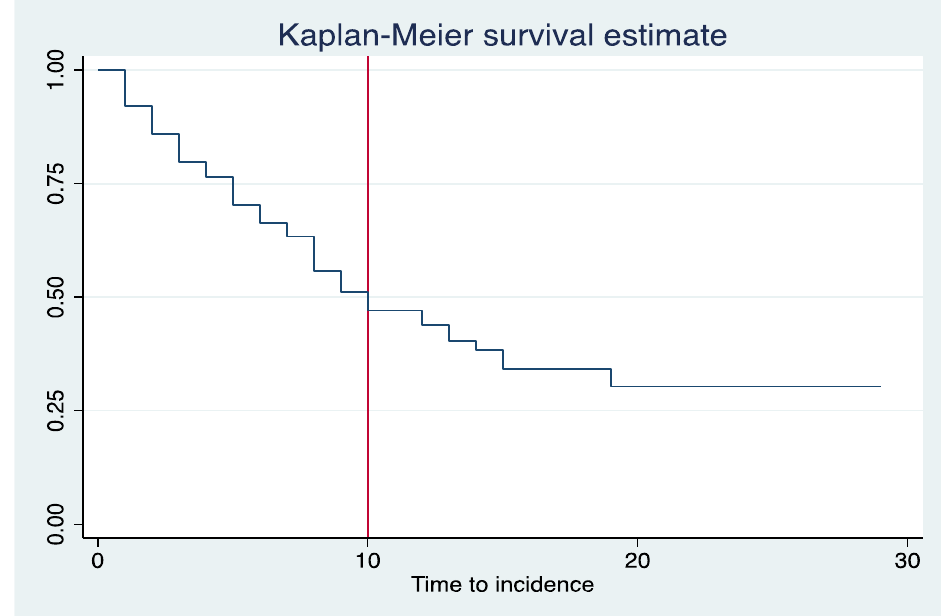
Figure 1. Kaplan–Meier curve for the incidence of AKI among colistin-treated patients.